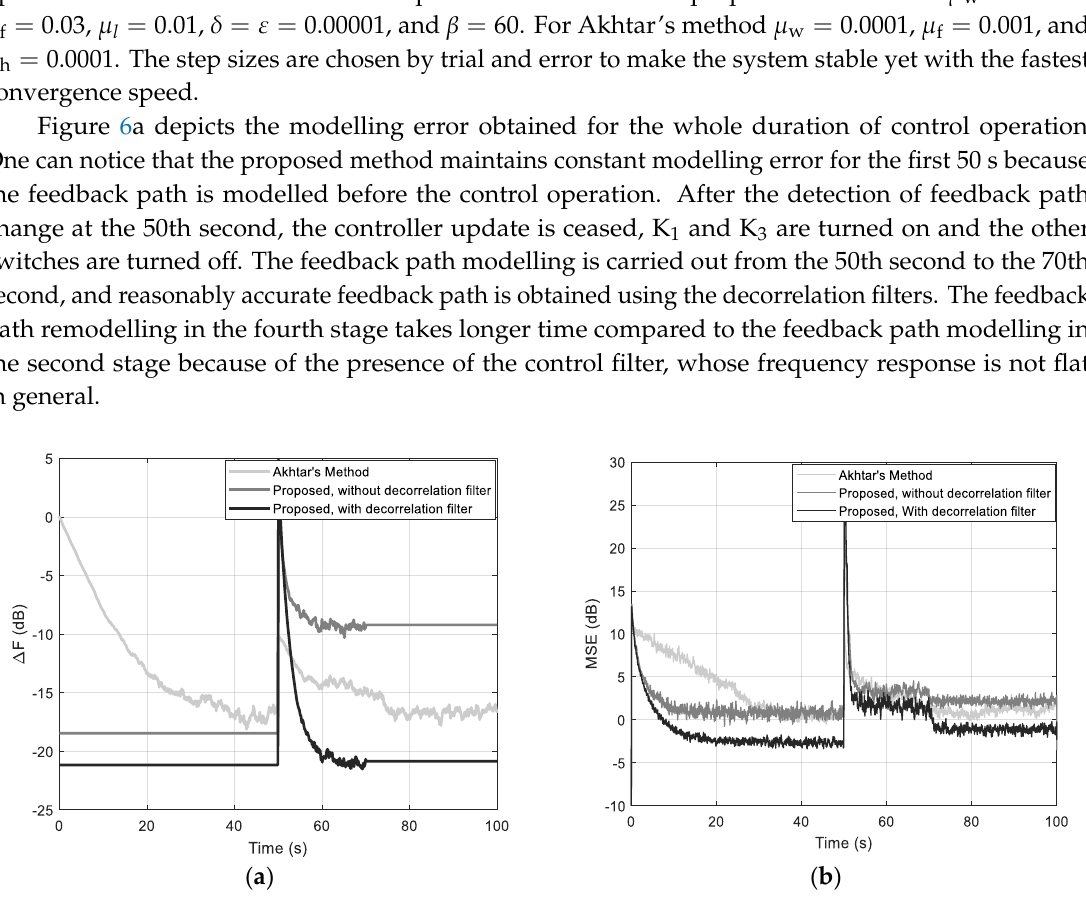
Figure 6. ( a ) Feedback path modelling error, ( b ) learning curve for the whole duration of control